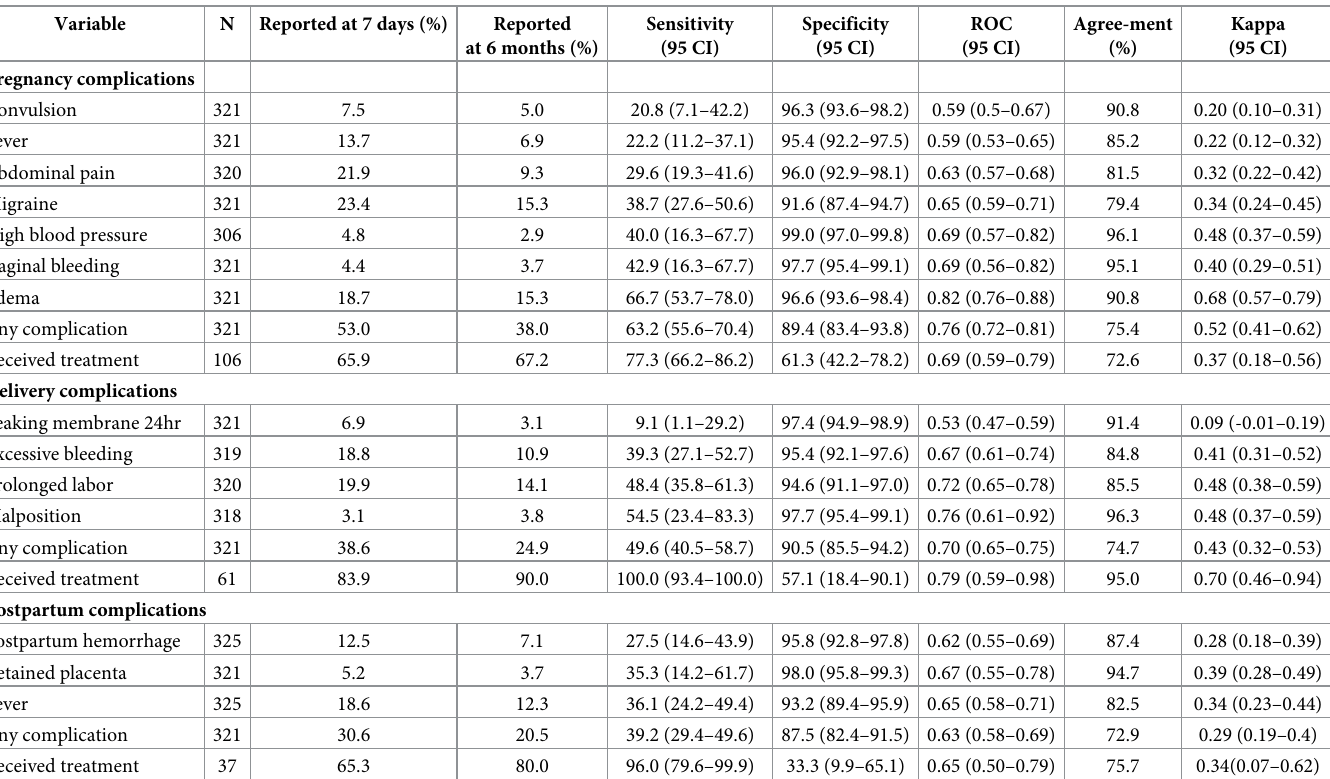
Table 5. Agreement diagnostics for select maternal pregnancy, delivery, and post-partum complications reported at 7-day and 6-month follow-up visits. Variable N Reported at 7 days (%) Reported at 6 months